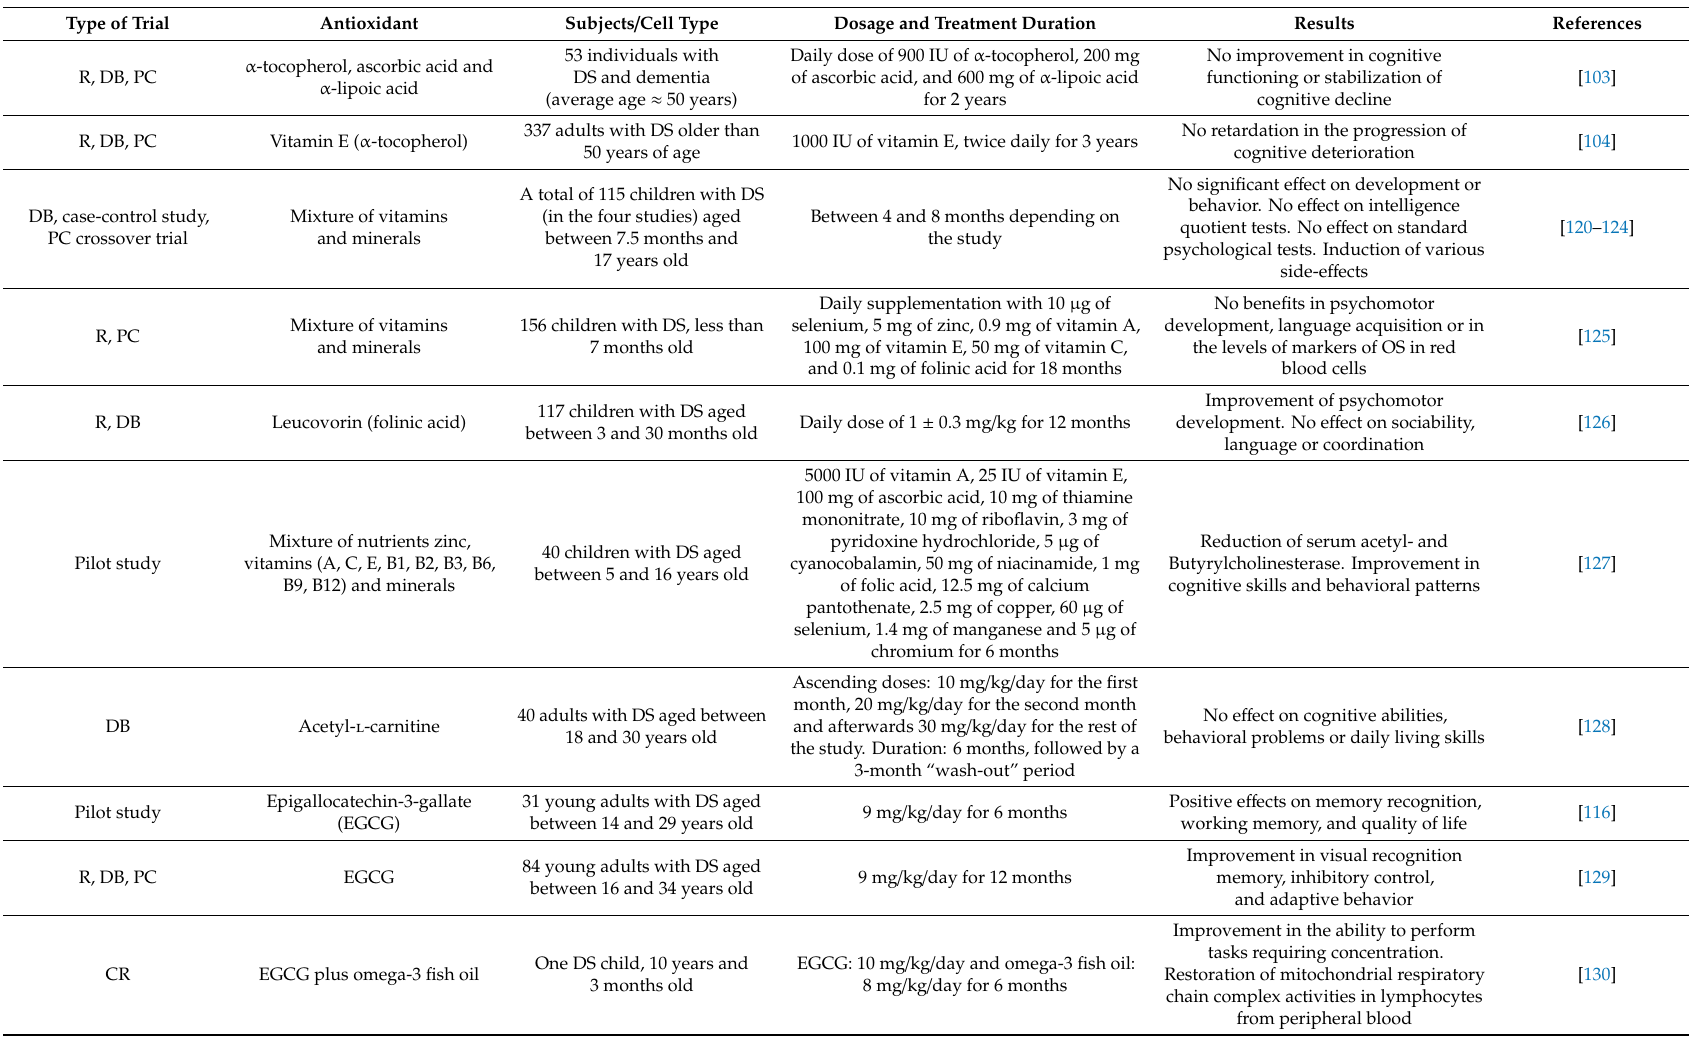
Table 2. Clinical trials that assessed the e ffi cacy of natural and synthetic molecules with antioxidant properties in DS